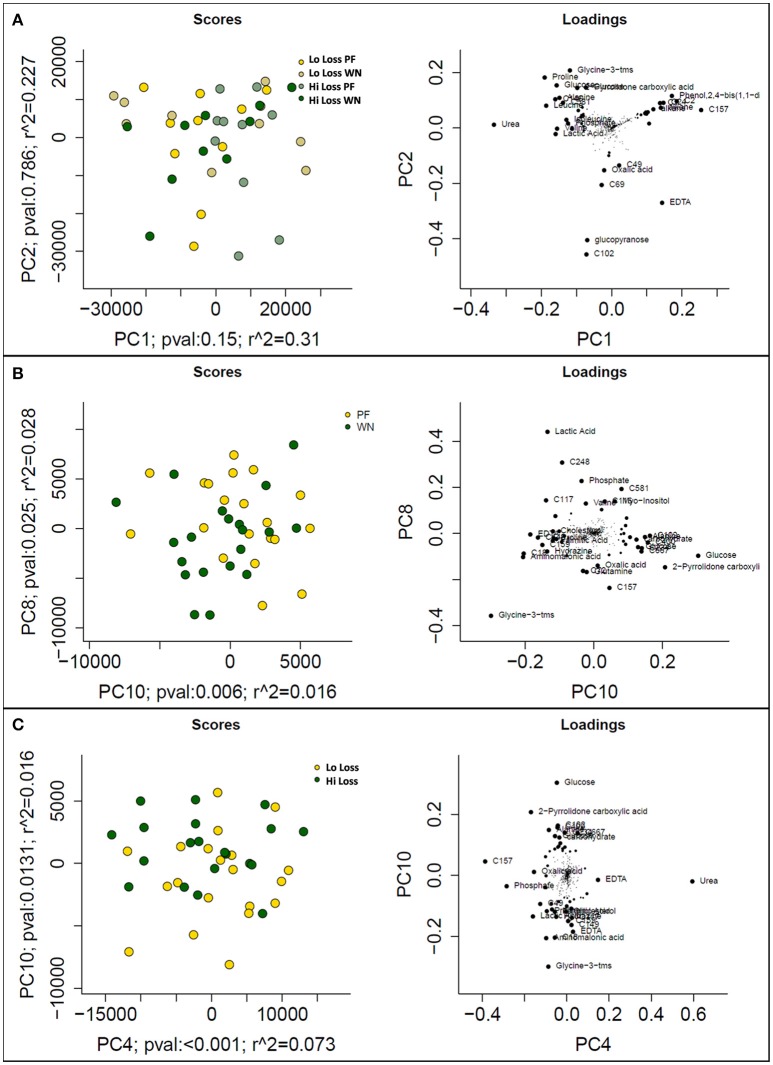
Prinicipal component analysis scores (left) and loadings (right) plots from Pareto scaled GC-MS dataset. (A) displays the maximal explained variance, plotting PCs 1 and 2, and shows no distinguishable pattern for time of sampling or body condition of dam. (B) plots optimal separation based on time of sampling (post-farrowing or weaning) after correcting for subject differences, and (C) plots optimal separation by body condition of dams (lo loss and hi loss) following adjustment for subject differences.